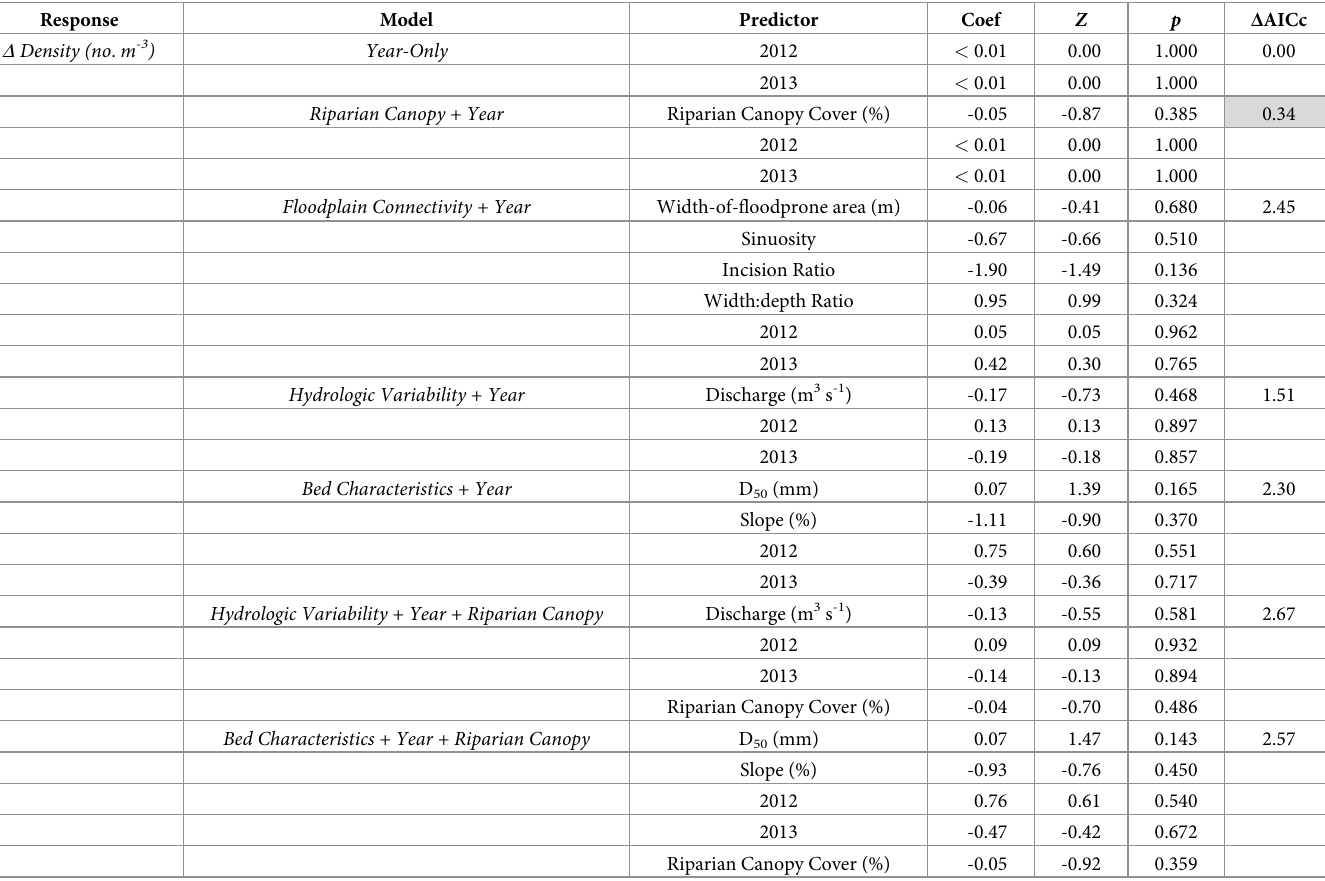
Table 5. Simple linear regression results for fish assemblage and hydrogeomorphic Δ variables with land use and water-chemistry variables. % Develop Pre-1990 % Imperviousness